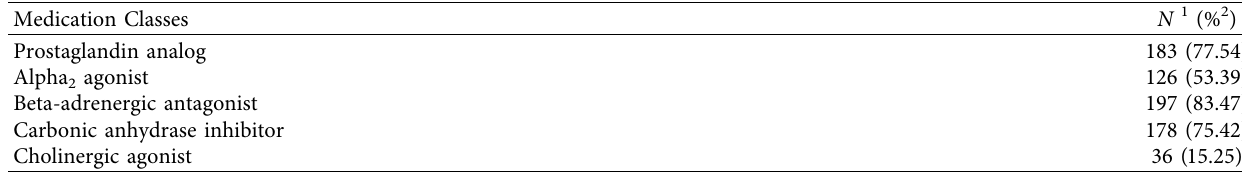
Table 3: Medication class representation for the adjunctive glaucoma agent(s) for total population.